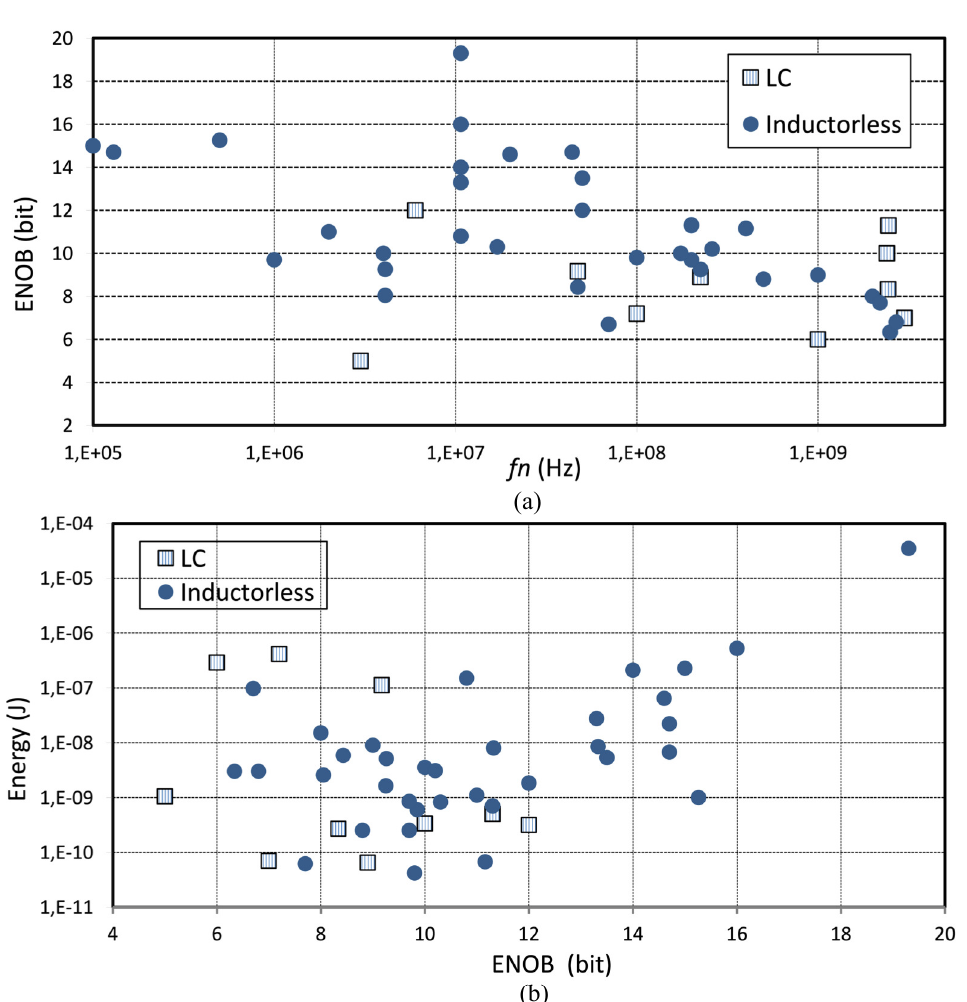
Figure 16. LC-based vs. inductorless BP- Σ∆ Ms: ( a ) ENOB vs. f n , ( b ) energy